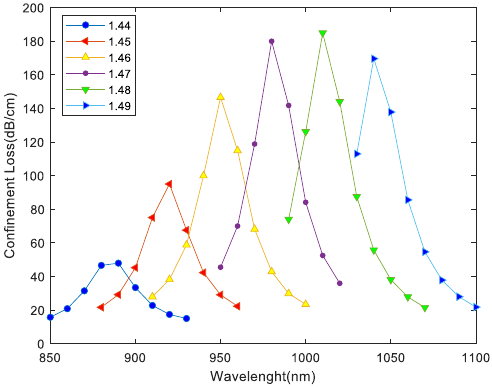
FIGURE 3. Fundamental mode confinement loss from n a =1.44 to 1.49. (d=2 μ m, d c =2.8 μ m, h a =0.45 μ m, t Au =0.05 μ m, n c =1.47)